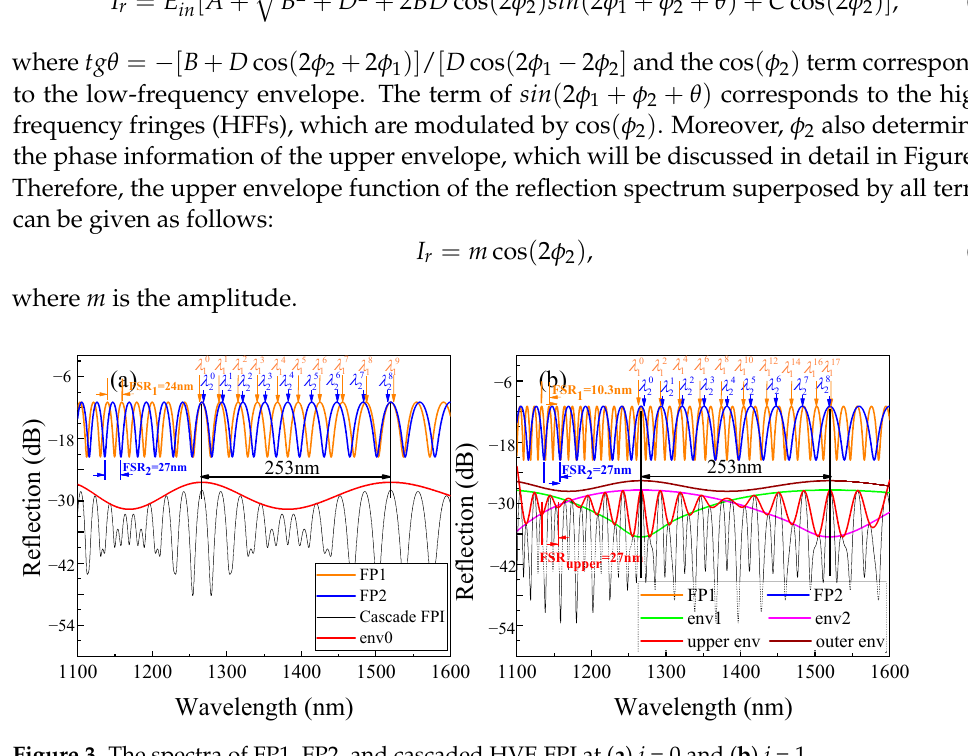
(in the calculation, k = 8). Figure 3a also shows the (cid:12)